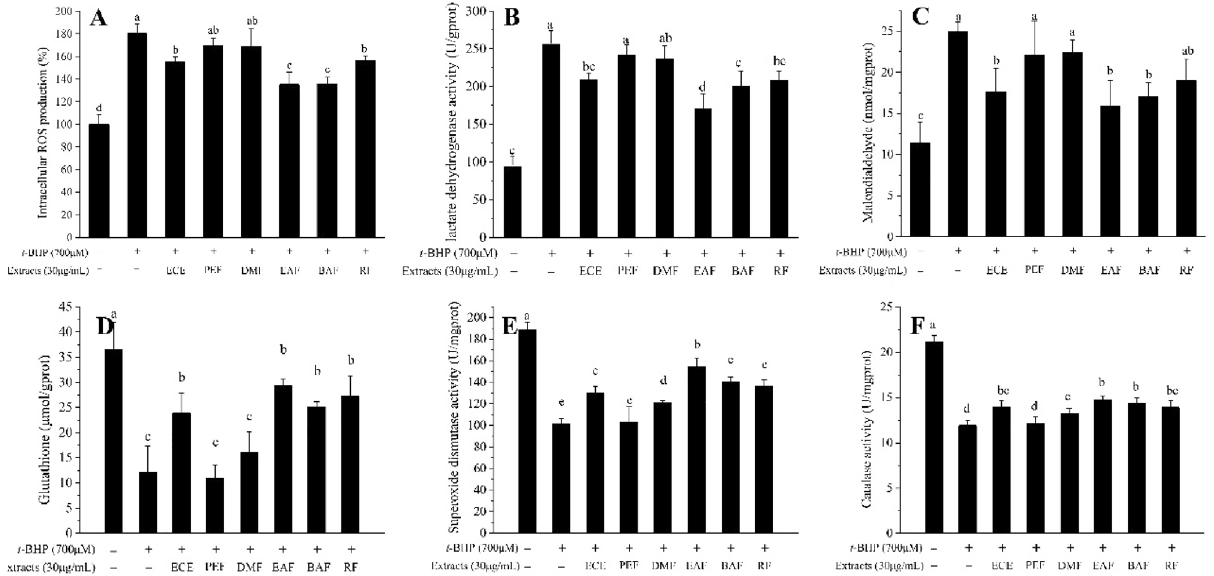
Figure 3. Effects of extracts on the indicators of HepG2 cellular antioxidant defense. ( A ) Effects of extracts on intracellular ROS. ( B ) Effects of extracts on extracellular lactate dehydrogenase activity. ( C ) Effects of extracts on extracellular malondialdehyde level. ( D ) Effects of extracts on GSH level. ( E ) Effects of extracts on SOD activity. ( F ) Effects of extracts on CAT activity. Different letters above bars indicate a significant difference (by ANOVA, p < 0.05). Results are expressed as mean ± SD (n ≥ 3). + , treated; −,